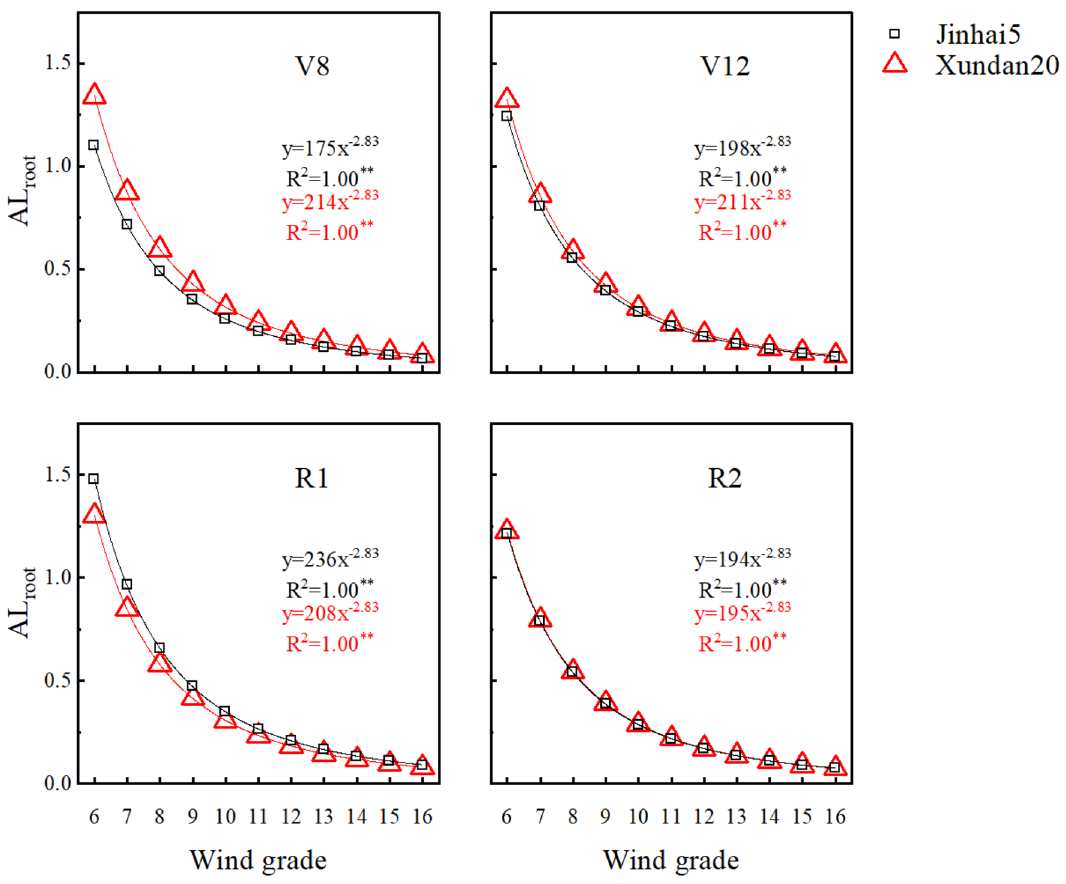
Figure 3. Root anti-lodging index as a function of wind grade at different growth stages for 2 tested cultivars in maize, **Statistically significant at 0.01 probability